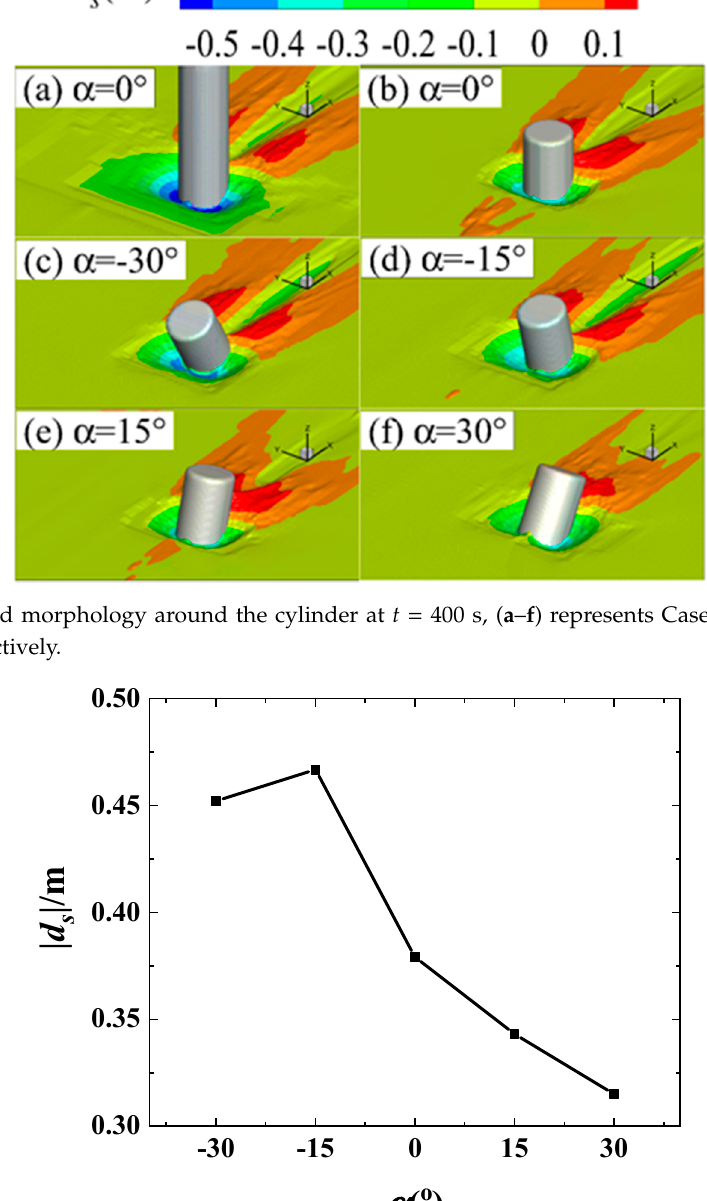
Figure 15. Maximum scour depth around the submerged cylinder with different inclination angles.